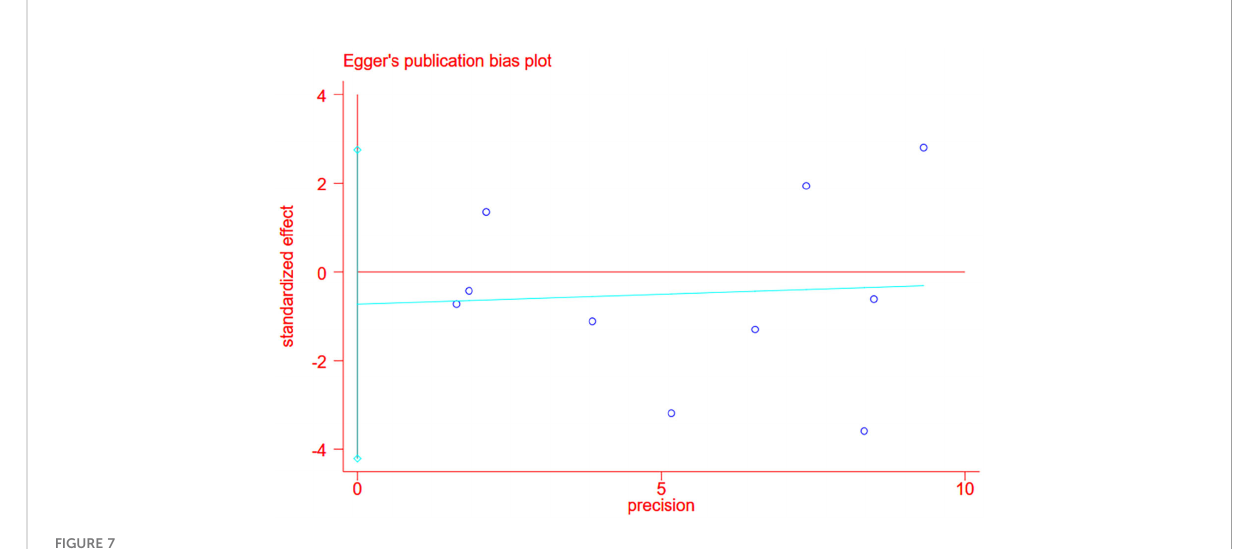
FIGURE 7 The plot of literature publication offset